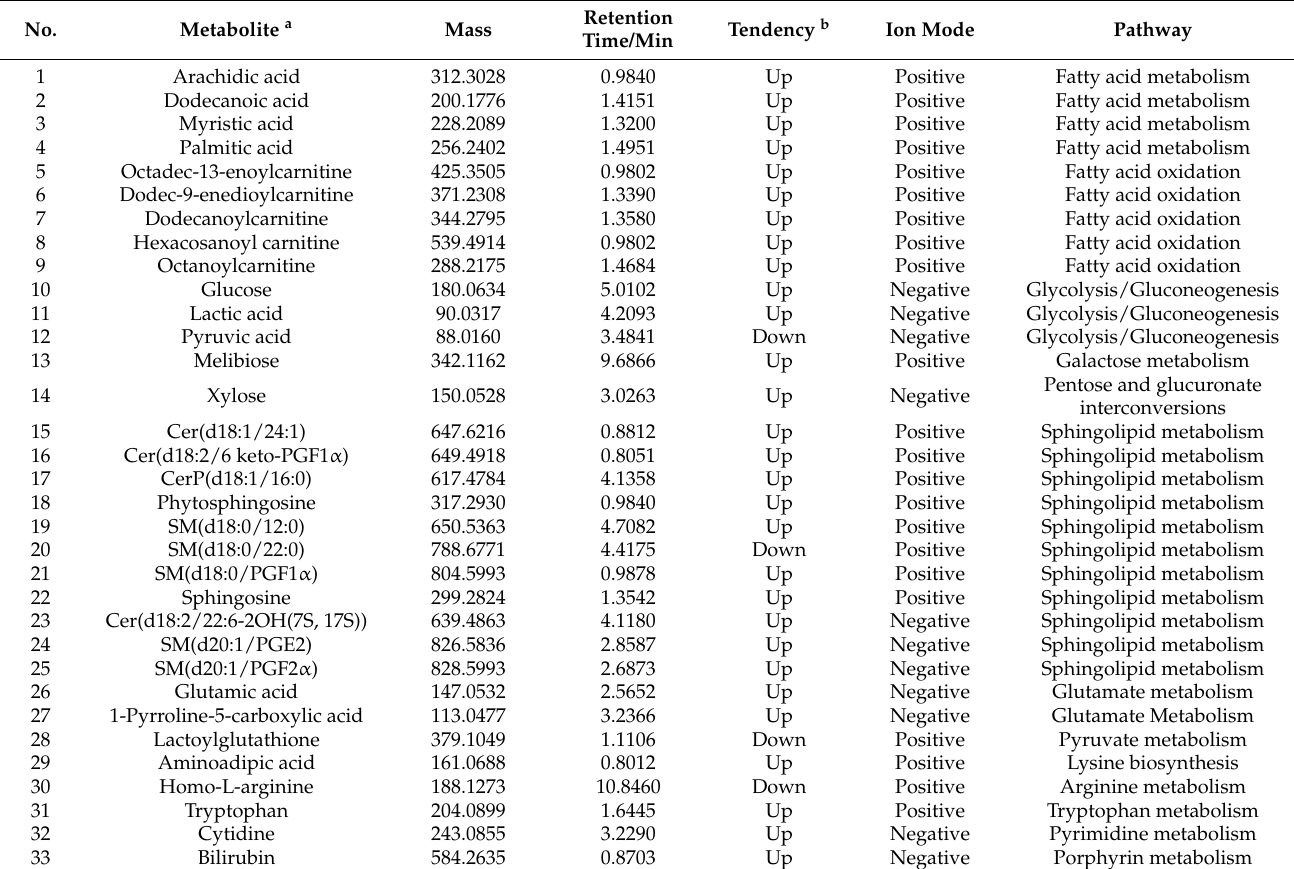
Table 1. Potential biomarkers for PV patients.